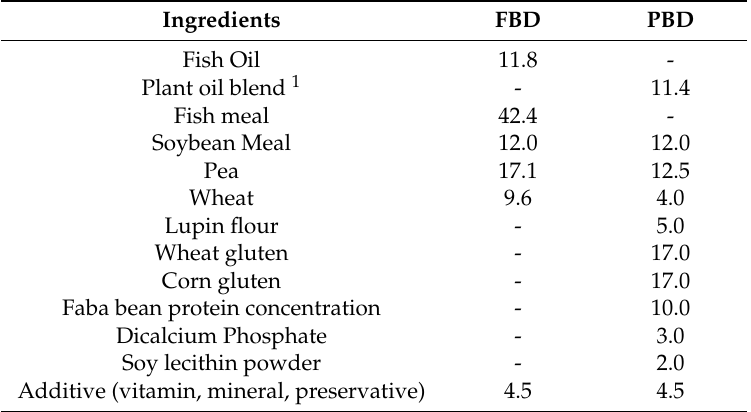
Table 1. The Ingredient of fish meal-based diet (FBD) and plant-based diet